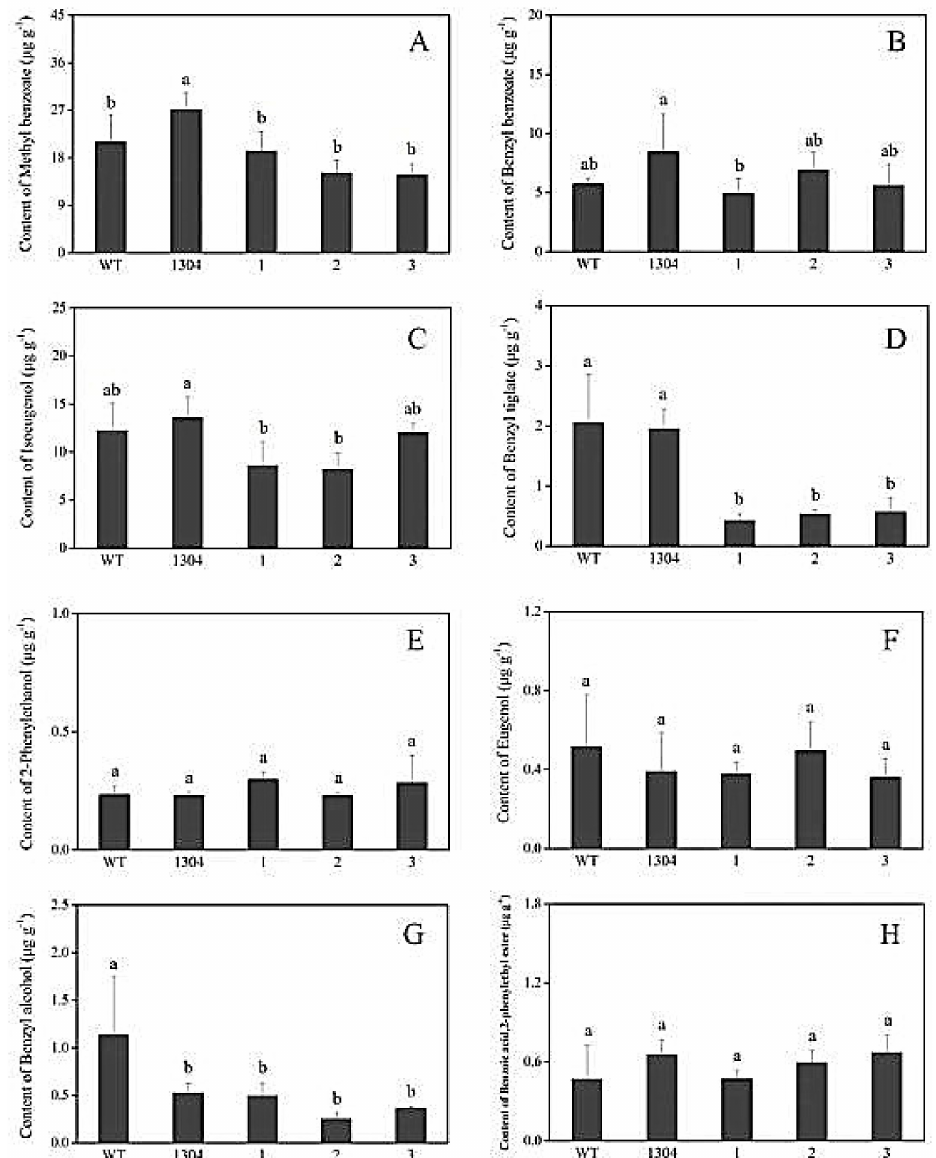
Figure 9. Analysis of the main volatile components in flower of RrPPDC1 transgenic and control Petunia